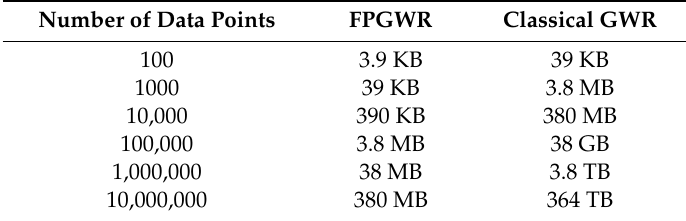
Table 6. The comparison of memory usage for FPGWR against classical